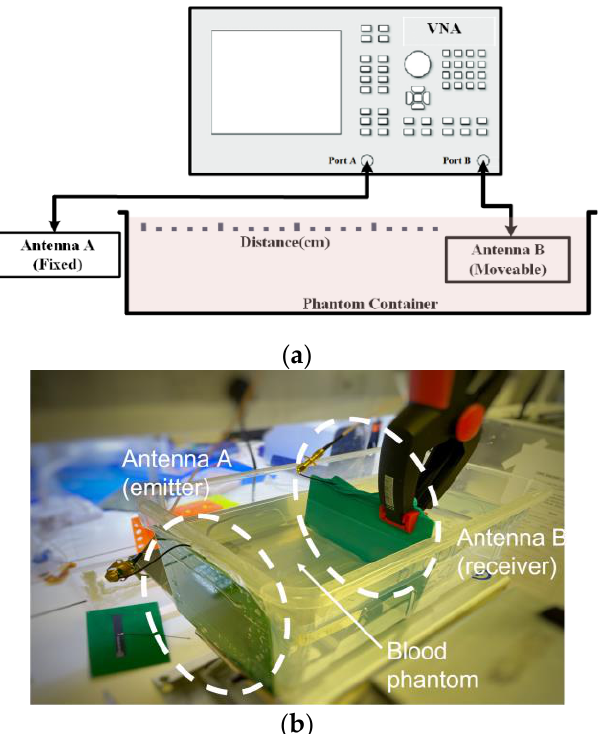
Figure 6. Experimental set-up for testing of communication bands; ( a ) schematic, ( b ) image of test- bench. Two antennas of the same frequency are connected to the VNA, with Antenna A outside the container. Antenna B is insulated with a latex glove and immersed in the blood phantom.